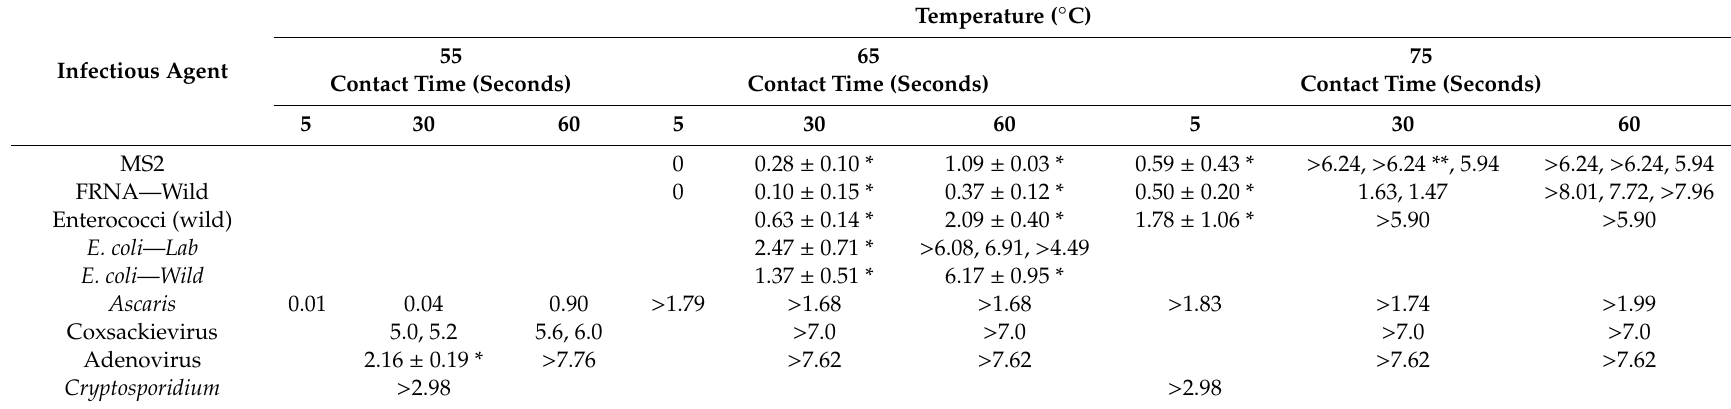
Table 3. Log reduction values achieved in laboratory trials at di ff erent temperatures and contact times in Western Treatment Plant (WTP) Pond 2 water.